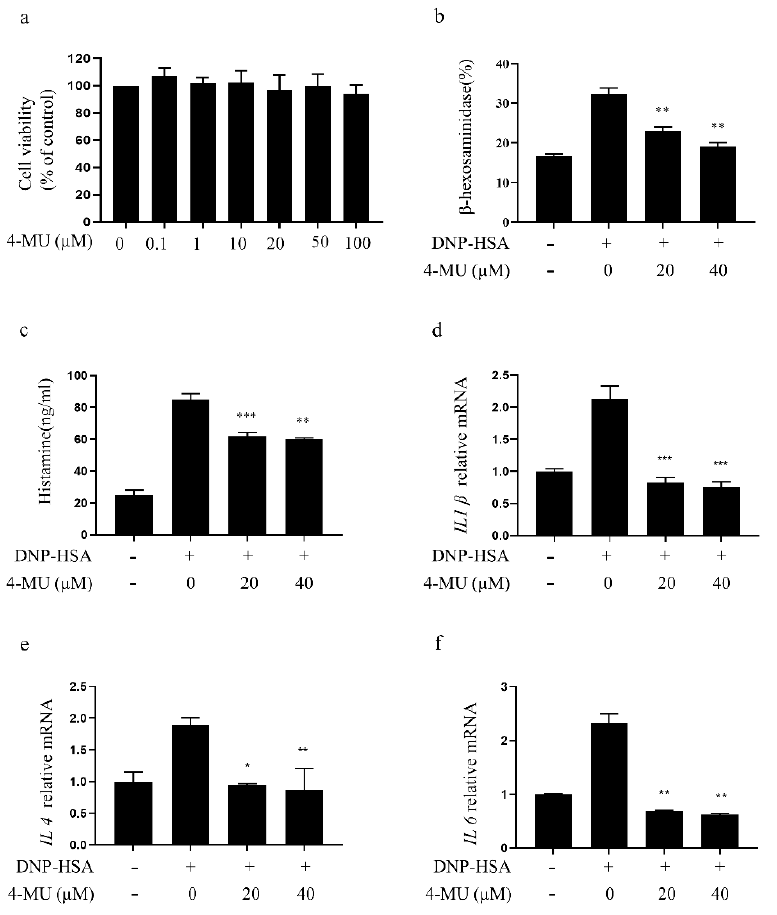
Figure 4. 4-MU inhibition of IgE/Ag stimulation of primary BMMCs. ( a ) Cell viability, as determined by CCK-8 assay, of BMMCs incubated with 0–100 µ M of 4-MU for 24 h. Cells were sensitized with anti-DNP IgE, with or without 4-MU, for 1 h, and then challenged with DNP-HSA. ( b ) β -Hexosaminidase release. ( c ) Histamine release. ( d – f ) mRNA expression of IL1 β ( d ), IL4 ( e ), and IL6 ( f ) determined by RT-qPCR. BMMCs were sensitized with anti-DNP IgE with or without 4-MU for 1 h and challenged with DNP-HSA for 4 h. Means ± SDs (of five duplicate experiments) are shown; * p < 0.05, ** p < 0.01, *** p < 0.001. Abbreviations as in Figure 1.